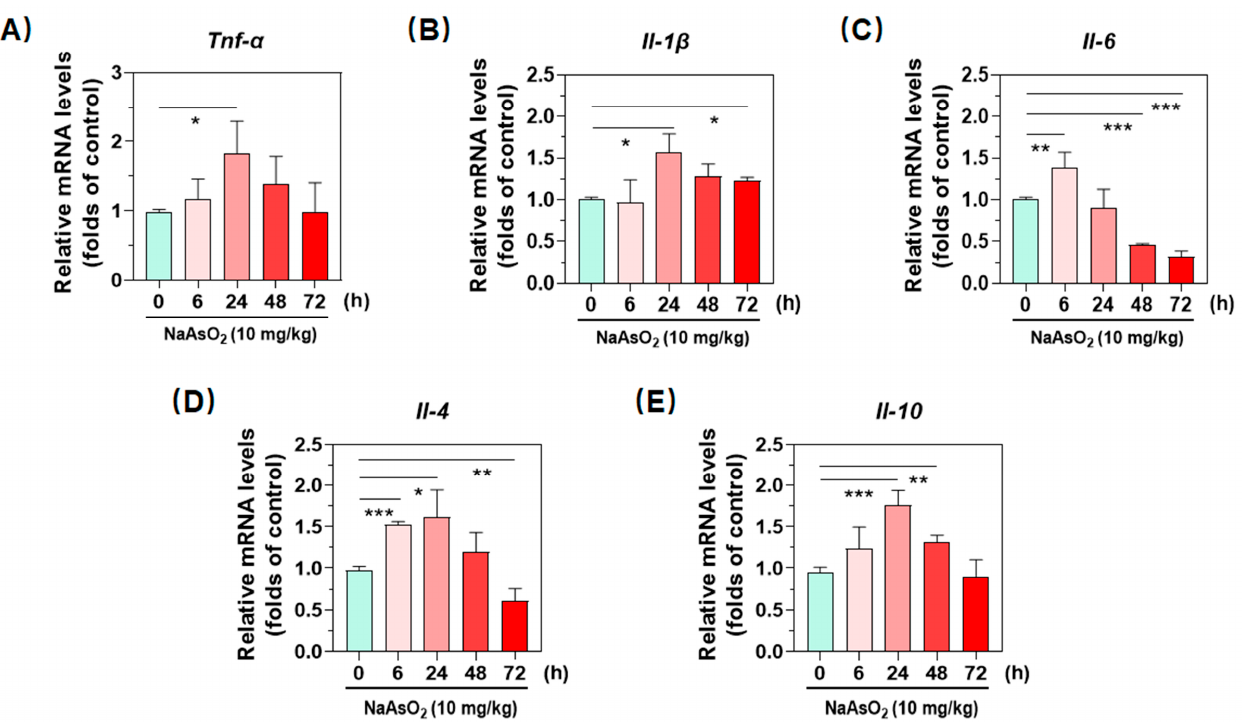
Figure 2. Enhanced gene expression of inflammatory cytokines in the livers of acute arsenic-exposed mice. ( A – C ) gene expression of proinflammatory cytokine Tnf- α , Il-1 β and Il-6 , ( D , E ) as well as anti- inflammatory cytokines Il-4 and Il-10 in liver were determined by real-time qPCR, of which relative mRNA levels normalized to Gapdh are shown at different time points after an oral administration of NaAsO 2 . Data are presented as mean ± SD ( n = 4). * denotes p < 0.05 compared with the control group. ** denotes p < 0.01 compared with the control group. *** denotes p < 0.001 compared with the control group.